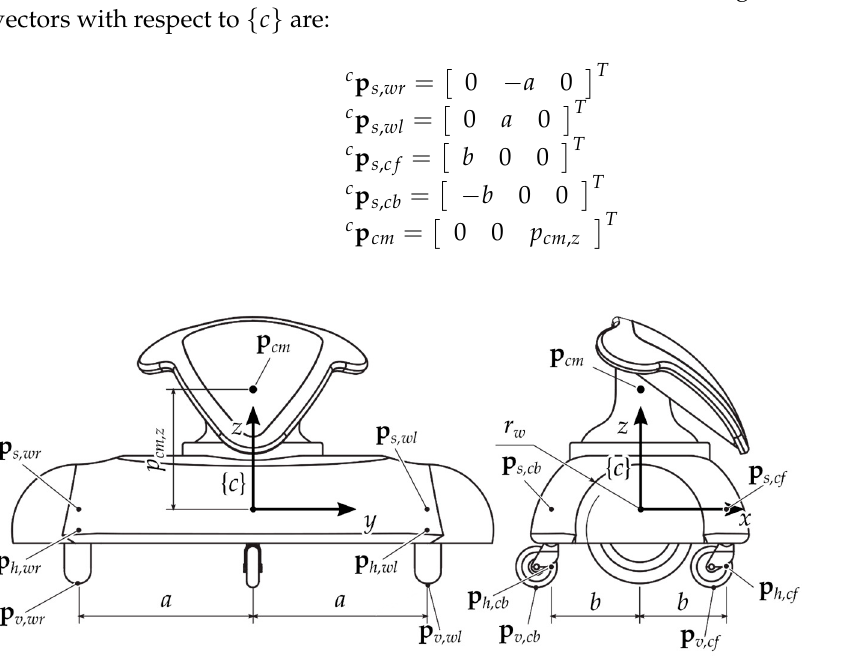
Figure 3. Relevant geometrical parameters of the